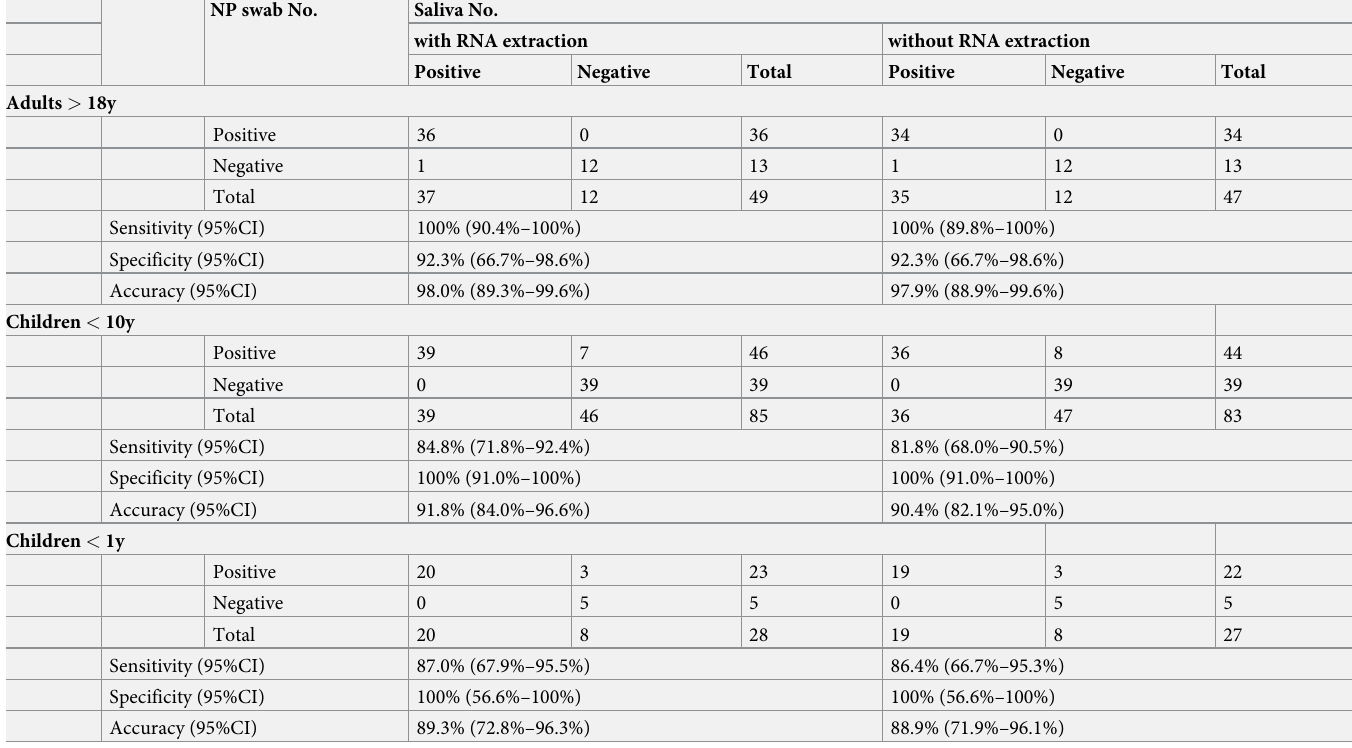
Table 1. Performance of saliva in adults and children. Summary of results obtained from parallel testing of NP swab and saliva samples with and without extraction of RNA. NP swab No.